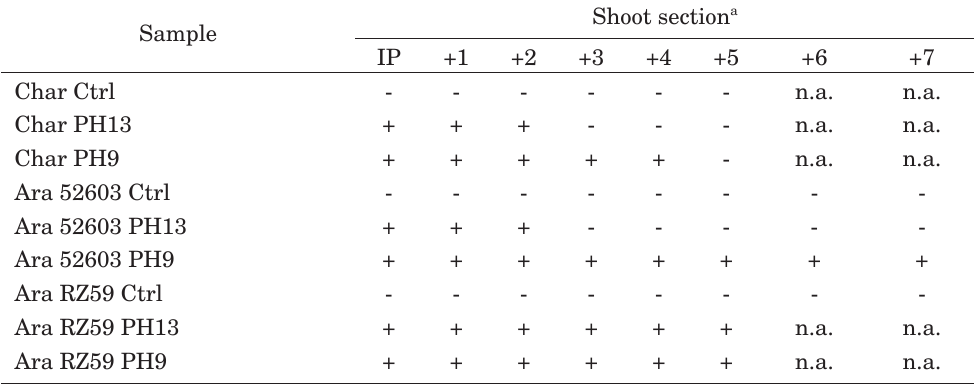
2. Occurrence of infection in shoot tissue from plants from cv. Chardonnay (Char) and cv. Aragonez clones (Ara 52603 and Ara RZ59) challenged with Pa. chlamydospora strains PH9 and PH13. Results from control plants (Ctrl) are also shown. Distance expressed in cm from the inoculation point (IP) section (1